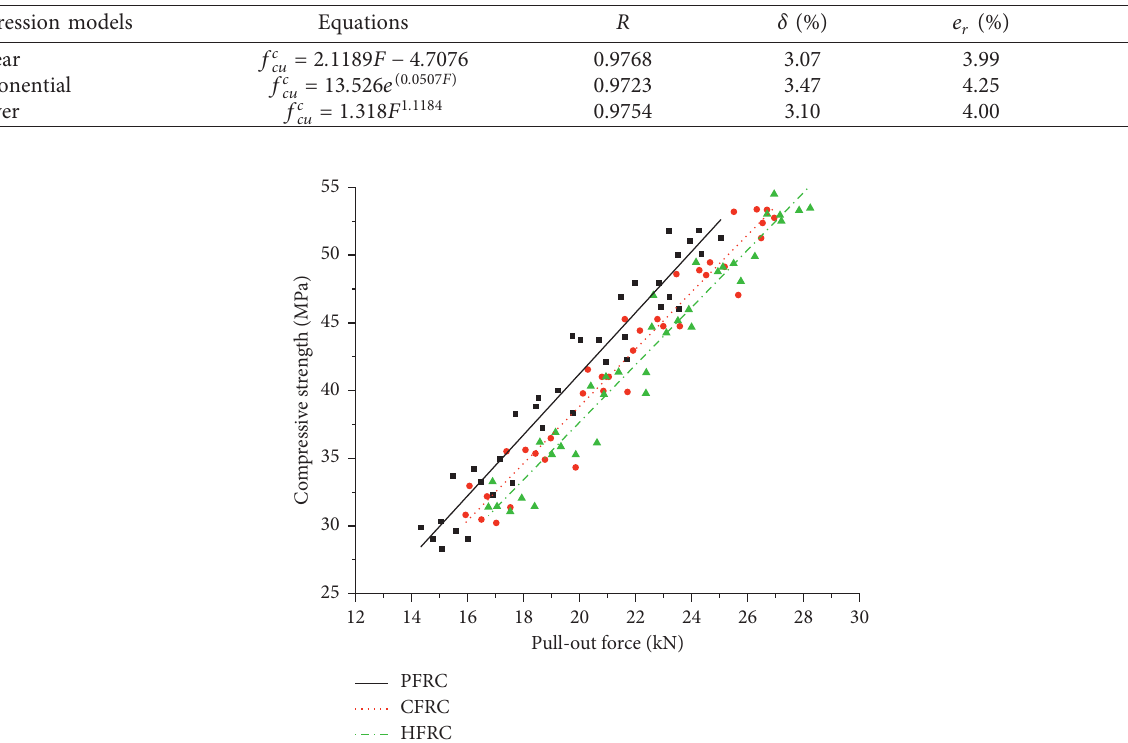
Figure 5: Relationship between pull-out force and compressive strength for three types of